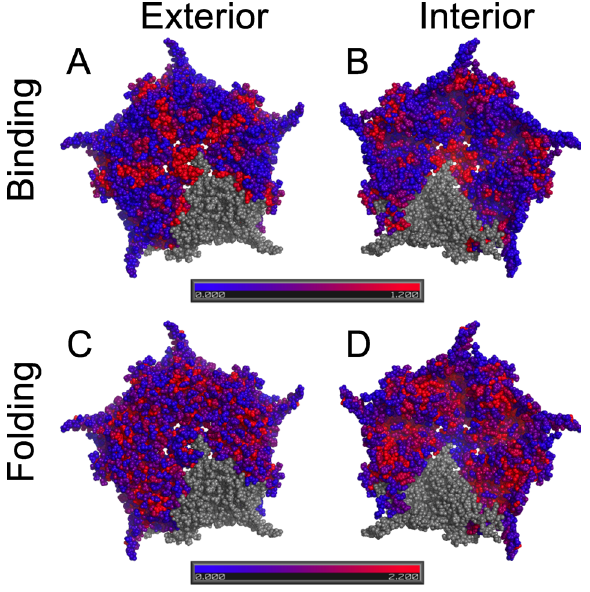
Figure 2. Heatmap of one pentamer showing median absolute effect size (i.e. | DD G |) at each residue among accessible substitutions. The figure illustrates that for binding stability, high effect residues are found along protein-protein interfaces while for folding stability, high effect residues are concentrated in the interior of the protein. Residues in red have large median effects; those in blue have small effects. Top panels (A and B) show effects on binding stability while lower two panels (C and D) show effects on folding stability. Left panels (A and C) show the exterior surface; right panels (B and D) show interior surface.